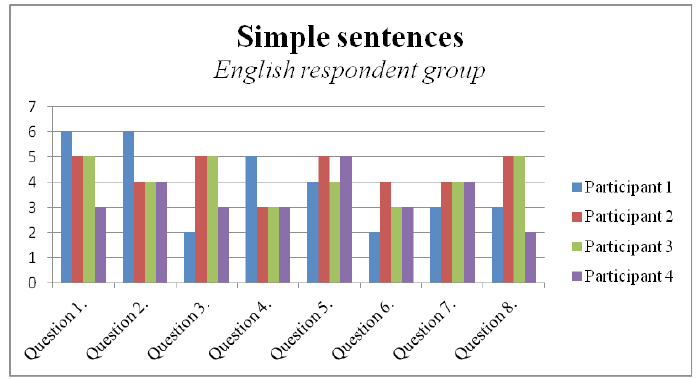
Graphic 8: Simple sentences - English respondent group.